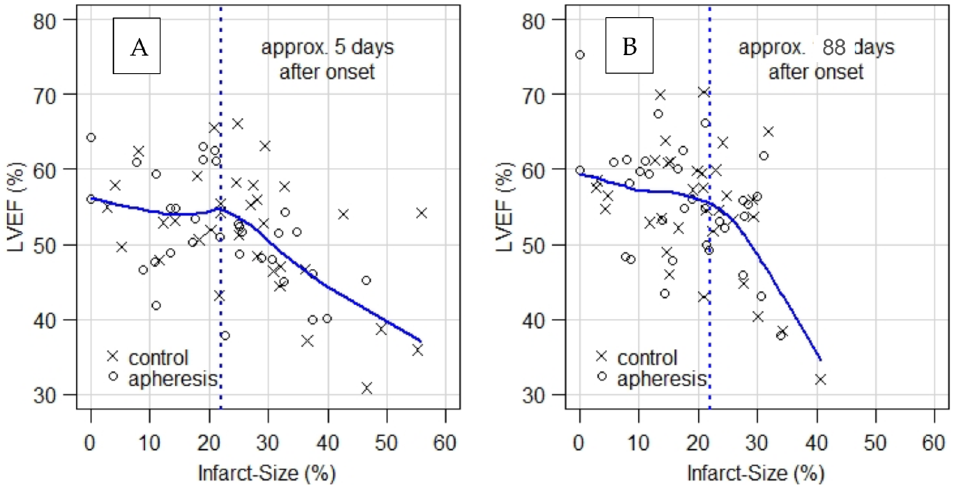
Figure 1. LVEF is plotted as a function of infarct size. Both plots (( A ) with data from CMR1 and ( B ) with data from CMR2) show a kink at infarct size ≈ 22%. That is, LVEF remains unchanged on average at the level of LVEF ≈ 55% up to about 22% of infarct size and decreases significantly beyond that point. CMR1 = first Cardio Magnetic Resonance, CMR2 = second Cardio Magnetic Resonanz, LVEF = Left Ventricular Ejection Fraction. Table 2. Results of CMR2 in patients with a CRP grad > 0.6 mg/L/h. CMR2 Mean ± Se Control Apheresis p -Value ( n = 21/34) ( n = 23/32) IS (%)